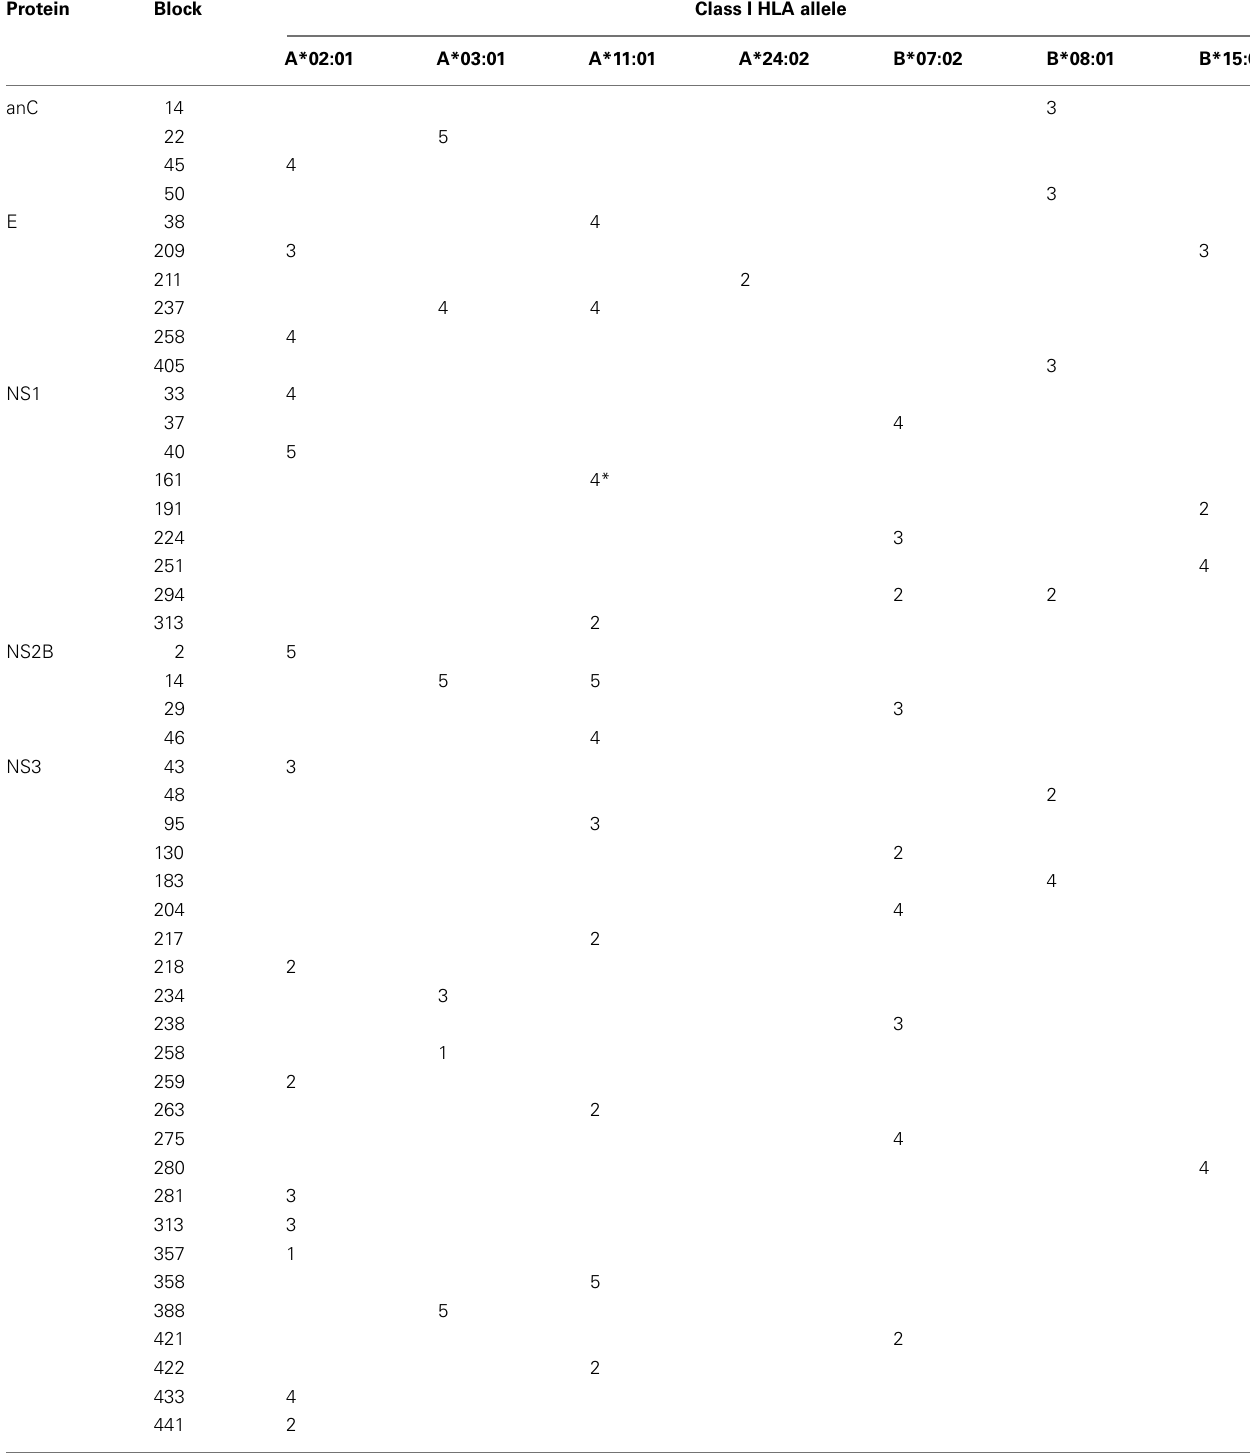
Table 4 | Conserved blocks with all peptides are predicted (NetMHC) to have high HLA binding affinity. Protein